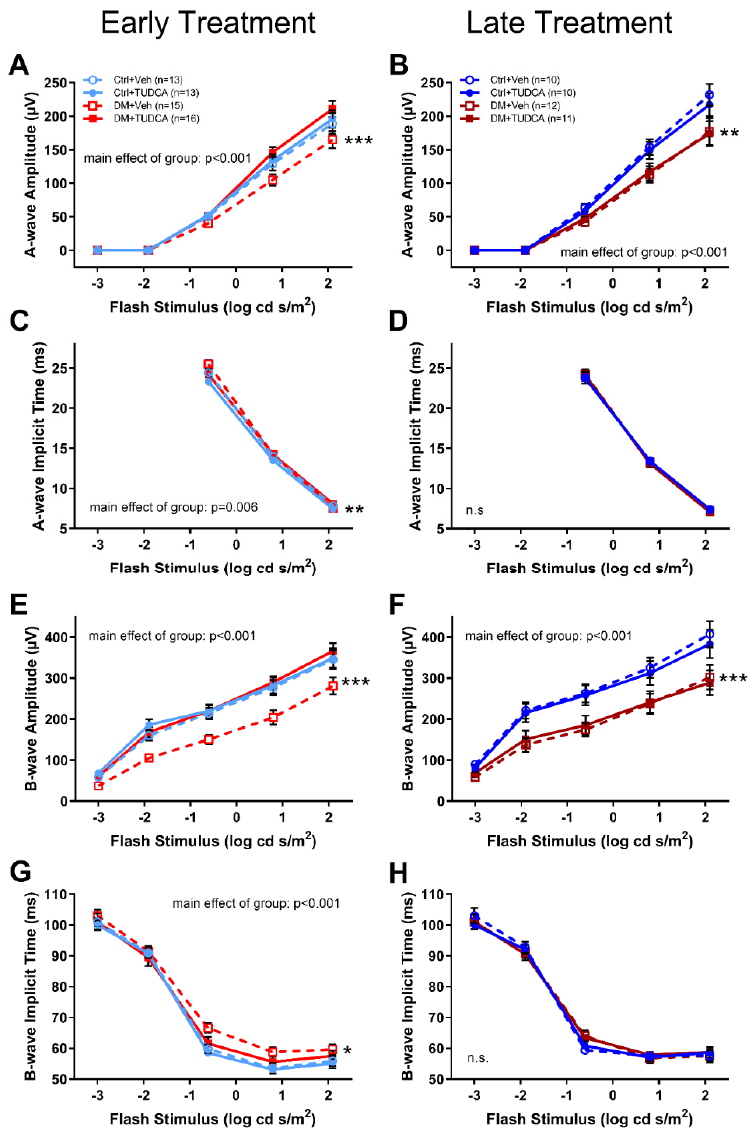
Figure 4. Early TUDCA treatment preserved ERG a- and b-waves in diabetic mice by 8 weeks post-STZ. ( A ) With early treatment, a-wave amplitudes in the DM+Veh group were significantly reduced compared to the DM+Veh, Ctrl+Veh, Ctrl+TUDCA groups (*** p < 0.001; two-way repeated measures ANOVA, F 12,298 = 4.121, main effect p < 0.001). ( B ) With late treatment, a-wave amplitudes were significantly reduced in the DM groups compared to the Ctrl groups (** p < 0.01; two-way repeated measures ANOVA, F 12,243 = 2.416, main effect of group p < 0.001). ( C ) With early treatment, a-wave implicit times were delayed in the DM+Veh group compared to all other groups (** p < 0.01; two-way repeated measures ANOVA, F 3,170 = 3.34, main effect of group p = 0.006). ( D ) With late treatment, a-wave implicit times were not significantly different. ( E ) With early treatment, b-wave amplitudes in the DM versus Ctrl groups (*** p < 0.001; two-way repeated measures ANOVA, F 12,282 = 2.421, main effect of group p < 0.001). ( F ) With late treatment, b-wave amplitudes were reduced in the DM+Veh group compared to the other groups (two-way repeated measures ANOVA, F 12,219 = 2.416, main effect p < 0.001). ( G ) With early treatment, b-wave implicit times in the DM+Veh group were significantly delayed compared to the other groups (two-way repeated measures ANOVA, F 12,282 = 2.46, main effect p < 0.001). ( H ) With late treatment, b-wave implicit times showed no significant differences. Holm–Sidak post hoc comparisons indicated by asterisks: * p < 0.05, ** p < 0.01, *** p < 0.001.